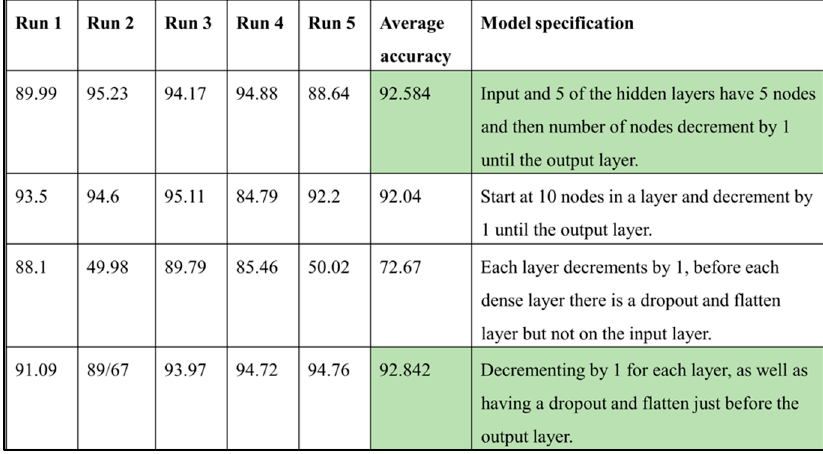
Figure 7. MLP experiment results highlighting the best average accuracies.